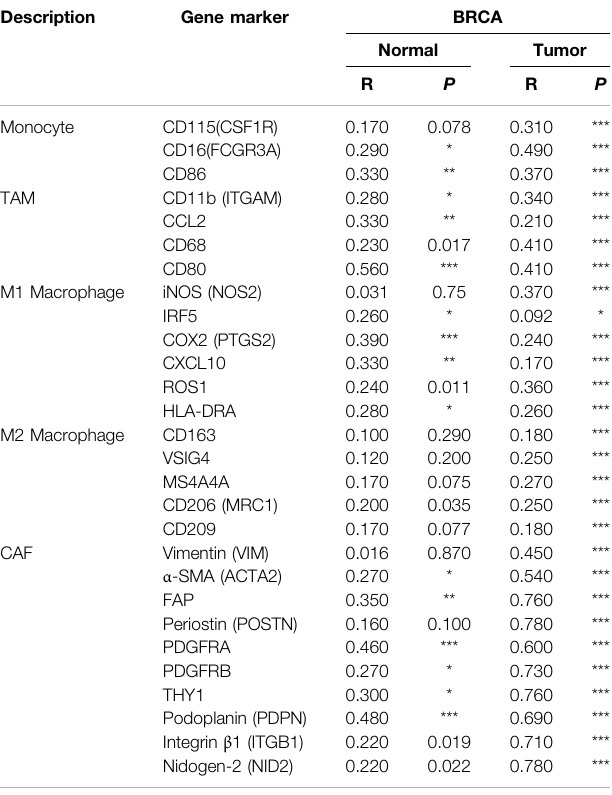
TABLE 4 | Correlation analysis between INHBA and related genes and markers of monocytes/macrophages and CAFs in GEPIA2. Description Gene